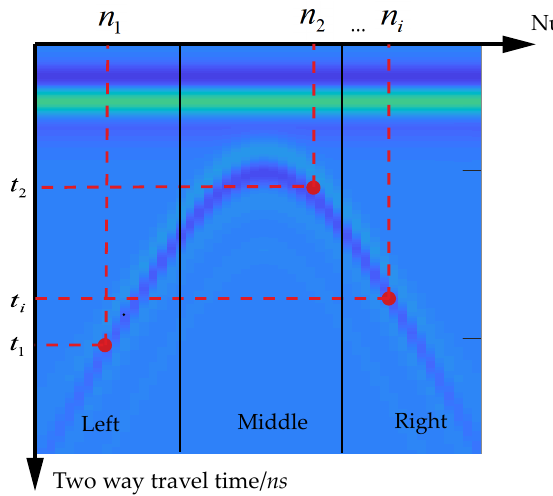
Figure 6. Select coordinate point.